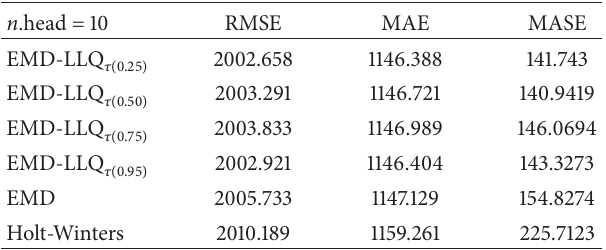
Table 2: Comparison of RMSE, MA, and MASE values for NZX50 using the Holt-Winter, LLQ, EMD, and EMD-LLQ